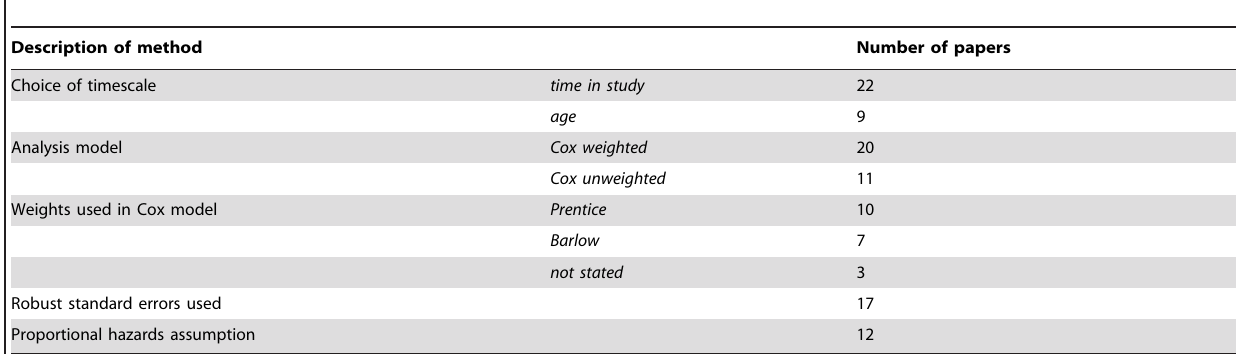
Table 2. Approaches to analysis reported in 31 papers identified in the review that used Cox